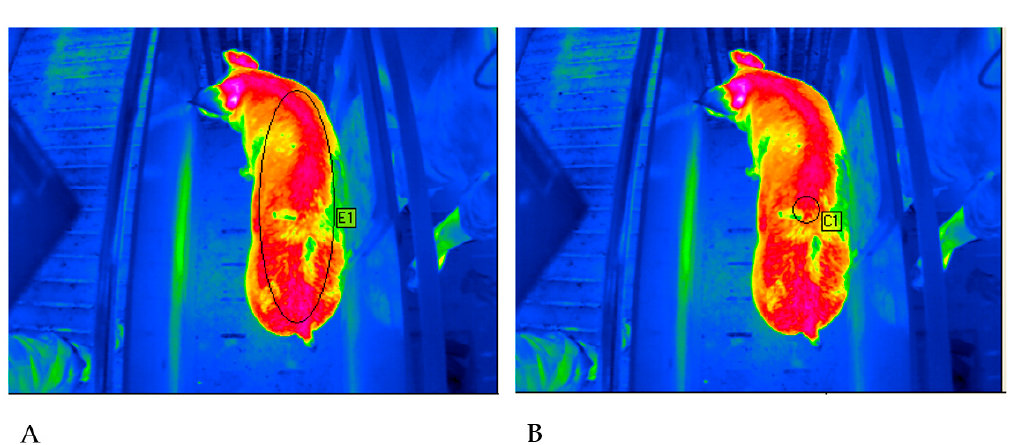
Figure 3. Thermogram of a fattening pig with visible soiling within the measurement spots. ( A ) Evaluation method ME (maximal ellipse). ( B ) Evaluation method SC (standardized circle) ( © Alfert).